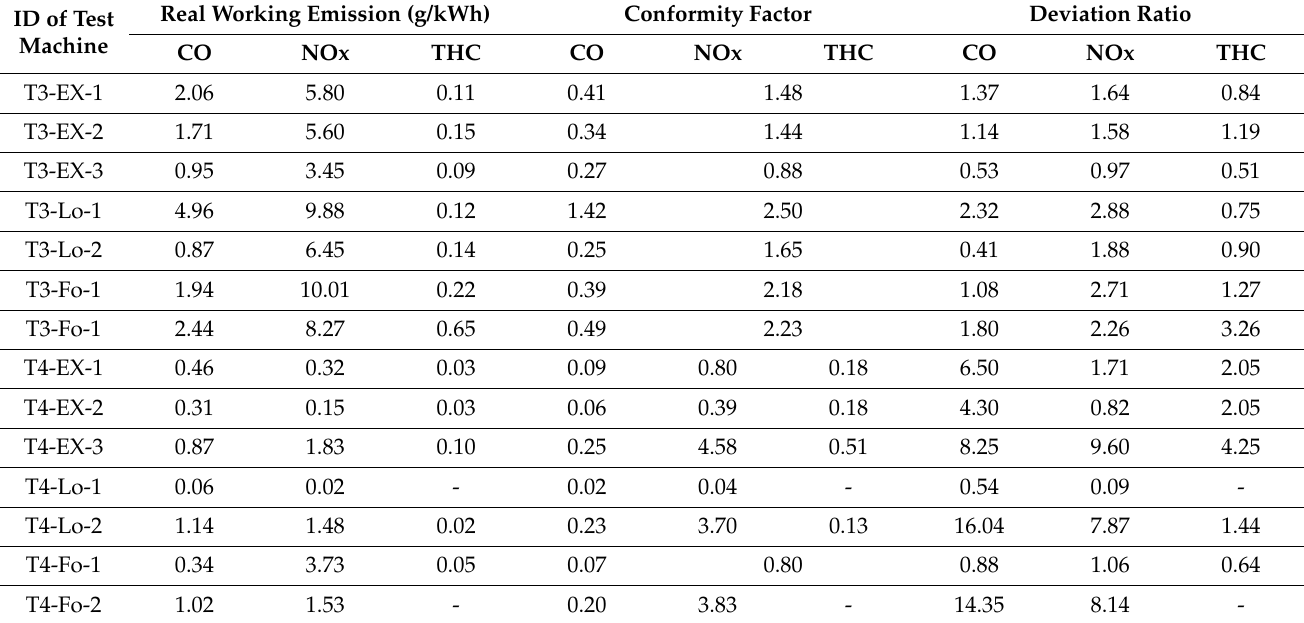
Table 4. Real working emissions, conformity factors and deviation ratios for the test construction